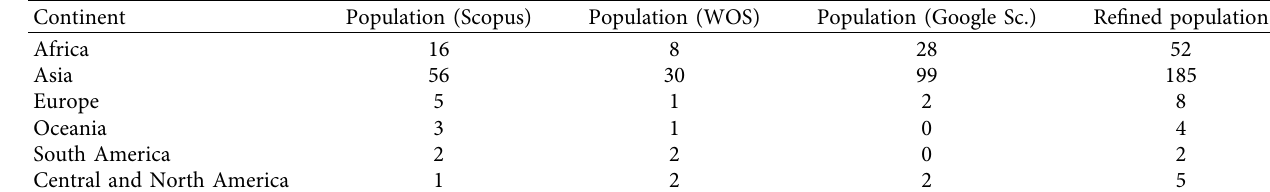
Table 1: Population size for papers related to construction delay in traditional projects.